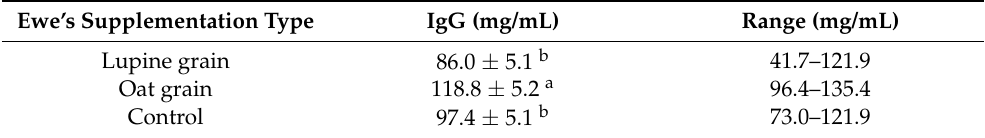
Table 3. Colostrum IgG concentration (means least squares ± standard error) in Merino Precoz ewes (least squares mean ± standard error) under different supplementation types.